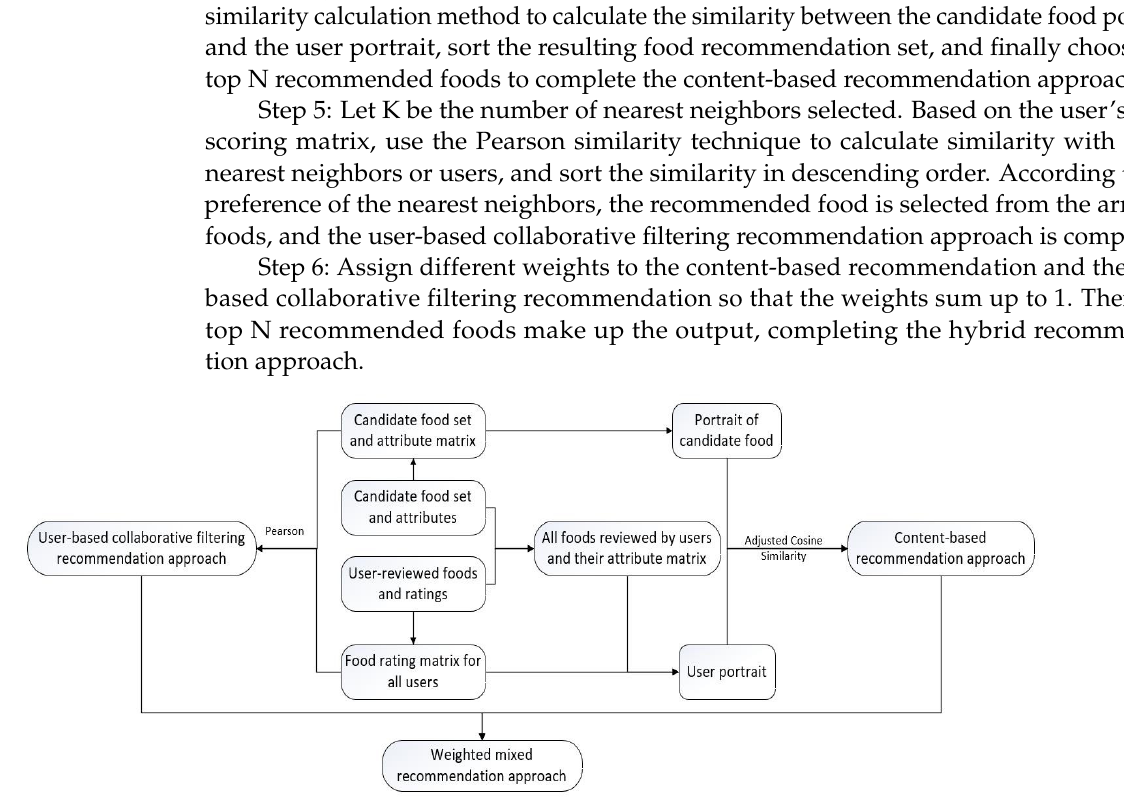
Figure 4. Flow chart depicting the hybrid recommendation approach.